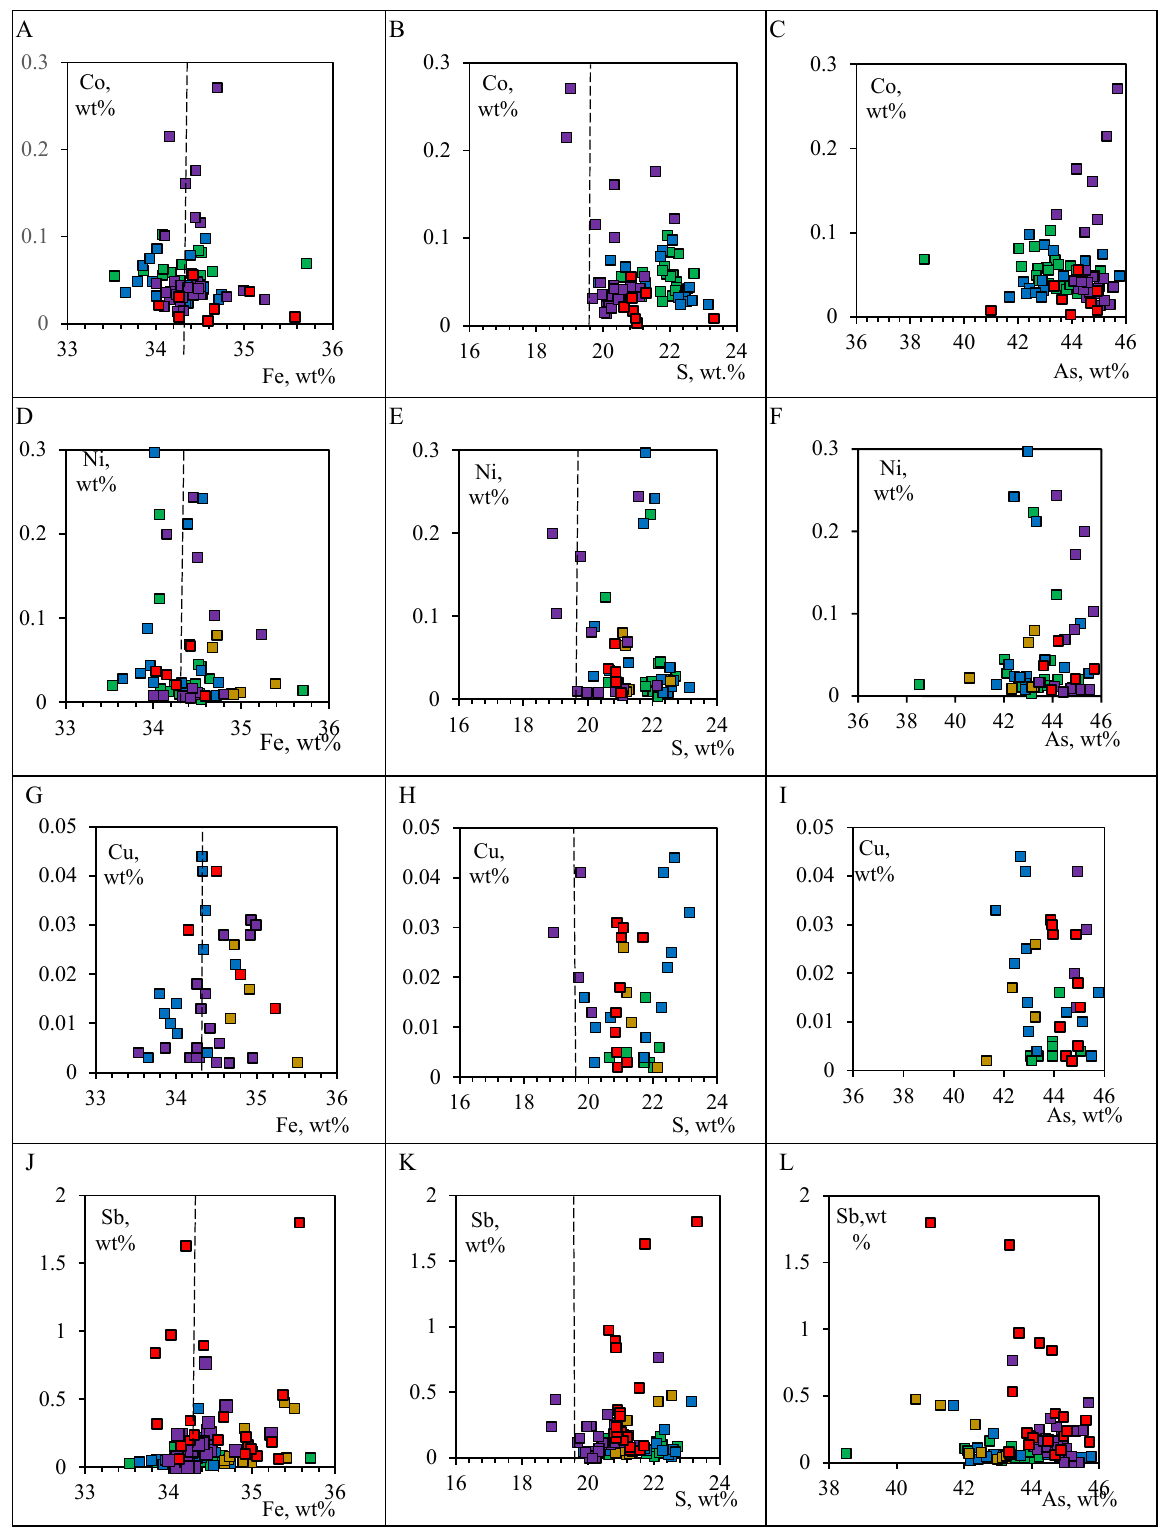
Figure 19. Diagrams of the ratios of concentrations of Fe, S, As, and trace elements in Apy1 of the studied OGDs, central YKMB. ( A ) Fe vs. Co; ( B ) S vs. Co; ( C ) As vs. Co; ( D ) Fe vs. Ni; ( E ) S vs. Ni; ( F ) As vs. Ni; ( G ) Fe vs. Cu; ( H ) S vs. Cu; ( I ) As vs. Cu; ( J ) Fe vs. Sb; ( K ) S vs. Sb; ( L ) As vs. Sb. The lines Fe = 34.30 wt%, S = 19.69 wt%, and As = 46.01 wt% correspond to the stoichiometric composi ‐ tion of pyrite. See symbols in Figure 16.